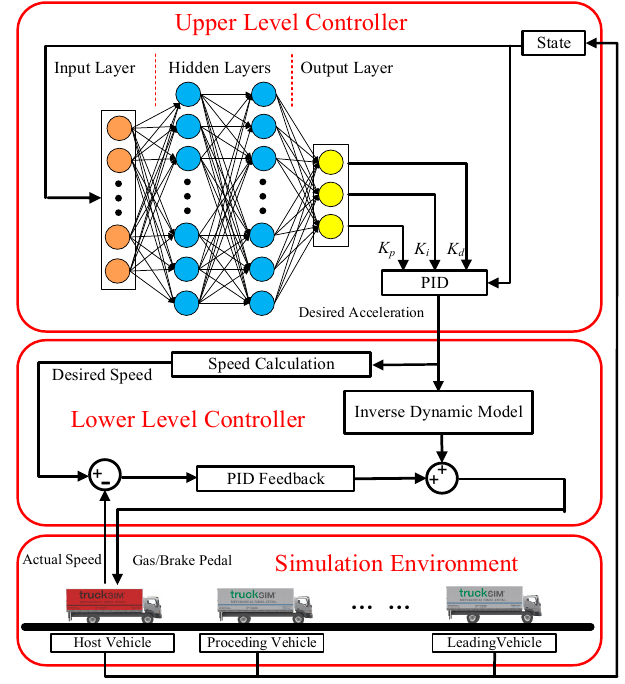
Figure 2. Hierarchical control structure.